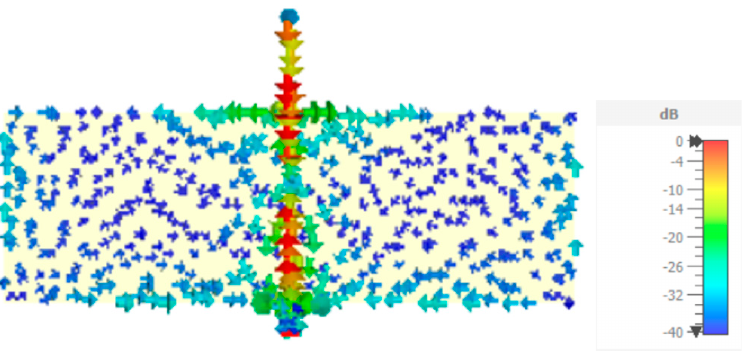
Figure 4. CST simulated current distribution of the straight monopole configuration at 2.3 GHz.